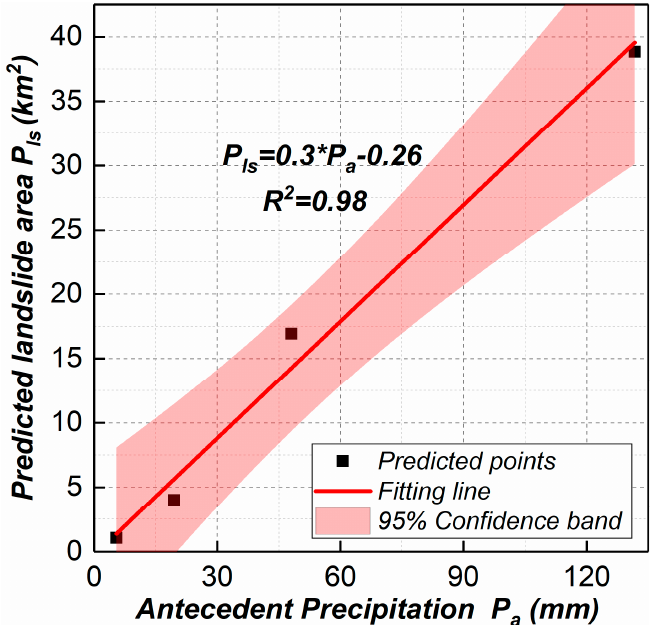
Figure 16. Relationship between antecedent precipitation (P a ) and the predicted landslide area (P ls ) for the four rainfall events.